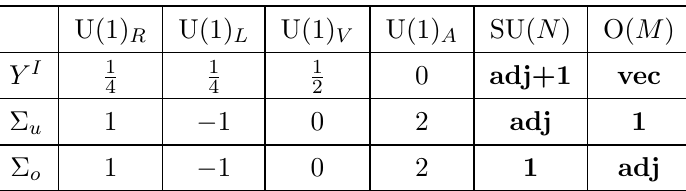
Table 5 . R-charges and representation content for the chiral and twisted chiral multiplets in the matrix-vector